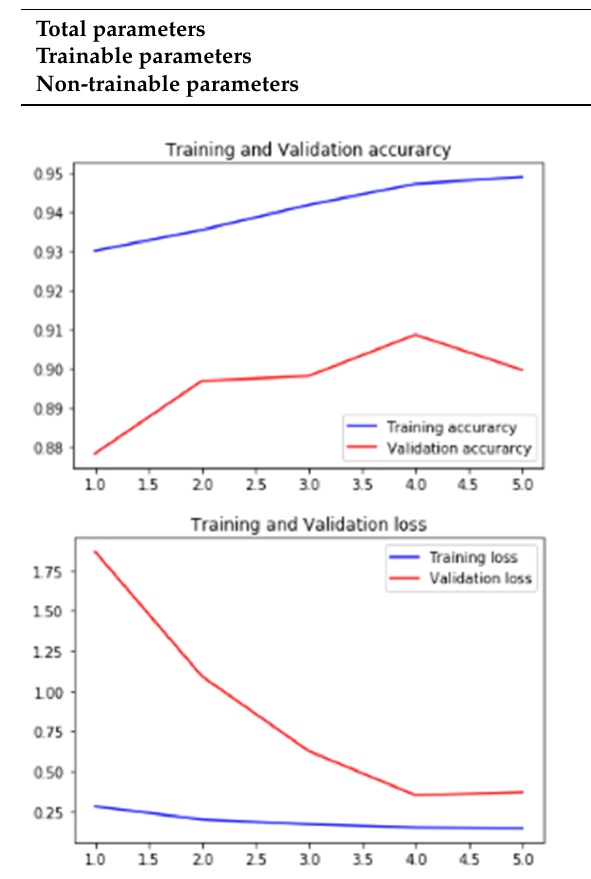
Figure 15. Classification Loss and Accuracy using ResNet network model.